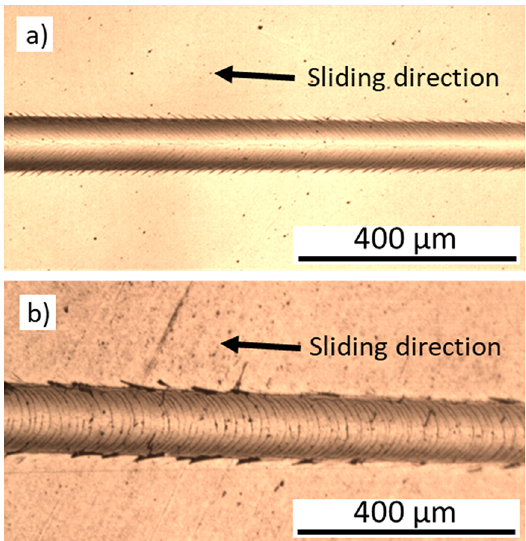
Figure 9. Image of the scratch taken at the mid length of the total scratch showing that the DLC film was not removed. Small